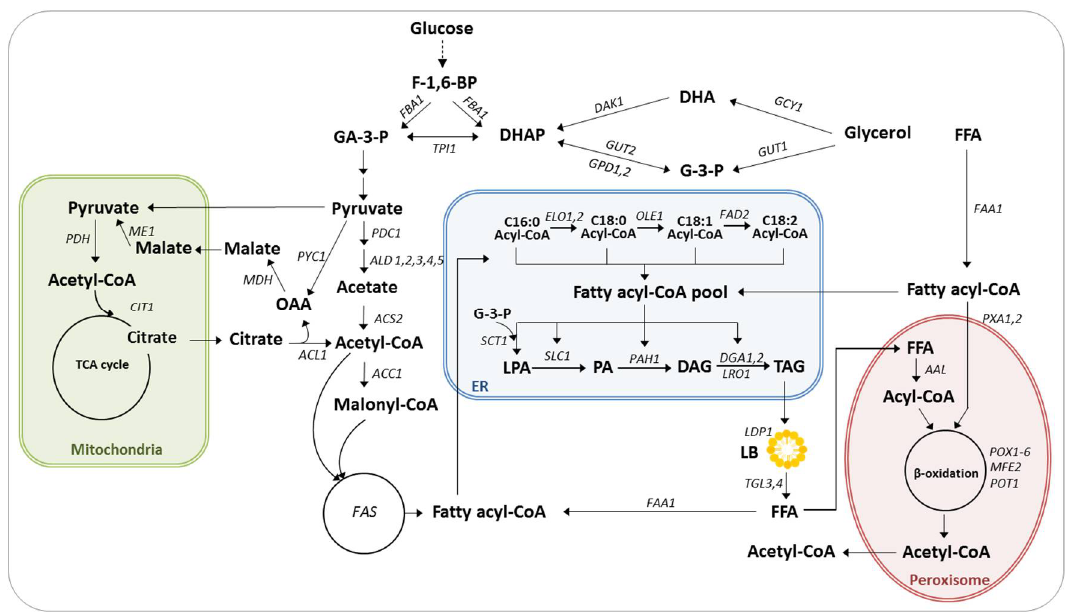
Figure 1. Lipid metabolism in Y. lipolytica . Abbreviations: F-1,6-BP, fructose-1,6-biphosphate; GA-3-P, glyceraldehyde-3-phosphate; DHAP, dihydroxyacetone phosphate; DHA, dihydroxyacetone; G-3-P, glycerol-3-phosphate; OAA, oxaloacetate; FFA, free fatty acid; LPA, lysophosphatidic acid; PA, phosphatidic acid; DAG, diacylglycerol; TAG, triacylglycerol; ER, endoplasmic reticulum; LB, lipid body; FBA1 , fructose biphosphate aldolase; TPI1 , triosephosphate isomerase; ME1 , malic enzyme; PYC1 , pyruvate carboxylase; MDH , malate dehydrogenase; PDH , pyruvate dehydrogenase; CIT1 , citrate synthase; CTP1 , citrate / malate transporter; PDC1 , pyruvate decarboxylase; ALD1-5 , aldehyde dehydrogenase; ACS2 , acetyl-CoA synthetase; ACC1 , acetyl-CoA carboxylase; FAS, fatty acid synthase; FAA1 , fatty acyl-CoA synthetase; GPD1 and GPD2 , glycerol-3-phosphate dehydrogenase; GUT1 and GUT2 , glycerol kinase; DAK1 , dihydroxyacetone kinase; GCY1 , glycerol dehydrogenase; ELO1, 2 , elongase; OLE1 , ∆ -9 desaturase; FAD2 , ∆ -12 desaturase; SCT1 , glycerol-3-phosphate O-acyltransferase; SLC1 , fatty acyl transferase; PAH1 , phosphatidate phosphatase; DGA1, 2 , DAG acyltransferase; LRO1 , phospholipid:diacylglycerol acyltransferase; LDP1 , lipid droplet protein; TGL3, 4 , TAG lipase 3 and 4; AAL , acyl / aryl-CoA ligase; POX1-6 , acyl-CoA oxidases 1-6; MFE2 , peroxisomal multifunctional enzyme 2; POT1 , 3-ketoacyl-CoA thiolase; LIP2,7 , and 8 , lipase; PXA1, 2 , peroxisomal ATP-binding cassette transporter complex; dashed lines, multistep metabolic route.